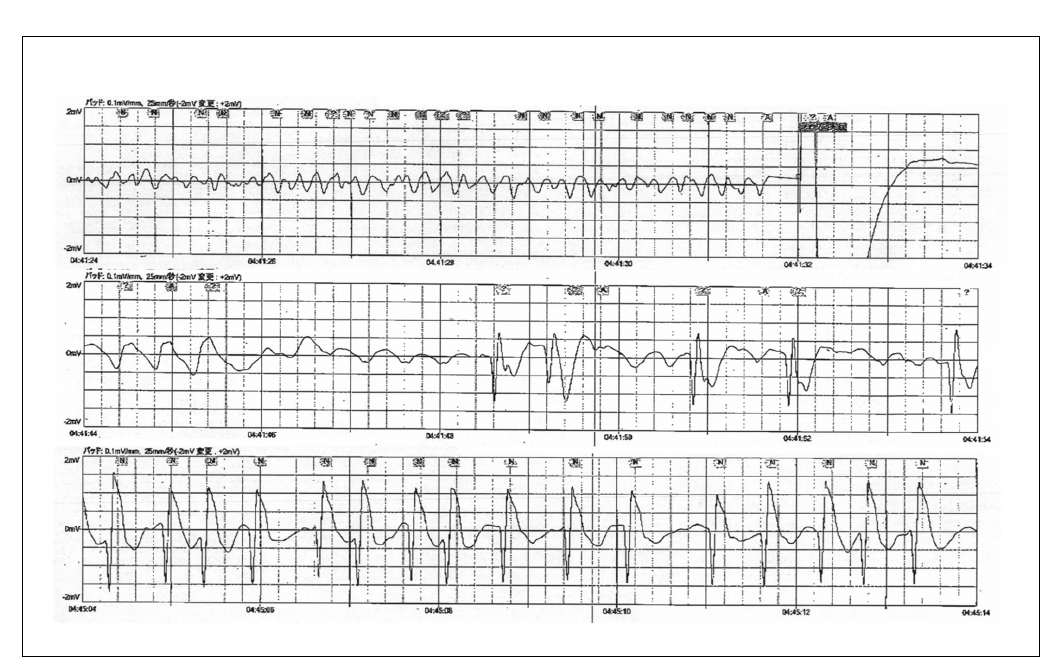
Figure 1. Electrocardiogram recorded by emergency responders showing ventricular fibrillation. After electrical shocks were delivered (the first column) and epinephrine was administered, spontaneous circulation was restored (the last